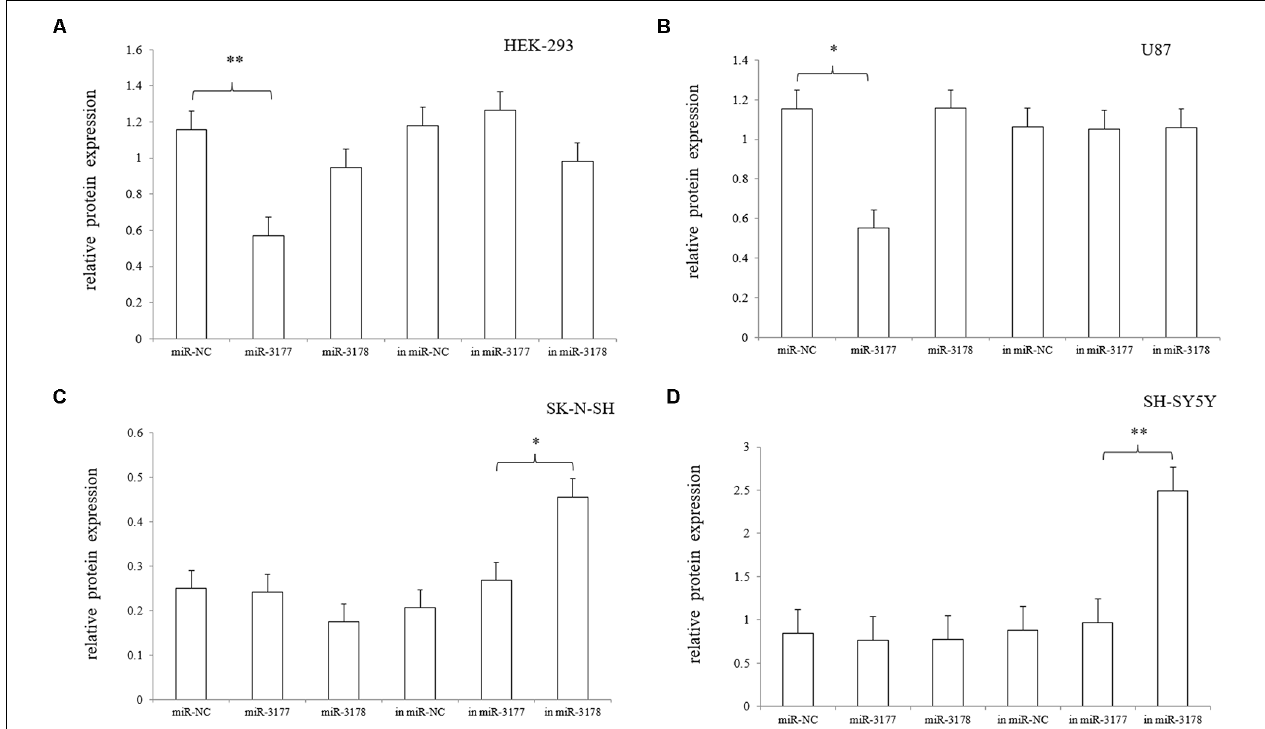
FIGURE 7 | Comparison of the gray values (A–D) . The effects of the hsa-miR-3177-5p mimic and hsa-miR-3178 inhibitor on endogenous 5-HT1A receptor reached statistical significance. Gray values for each sample were normalized using β -actin (relative protein expression) and are expressed as the mean ± SD. Student’s t -test was used for differential comparison. ∗ 0.02 ≤ p < 0.05, ∗∗ 0.001 ≤ p <